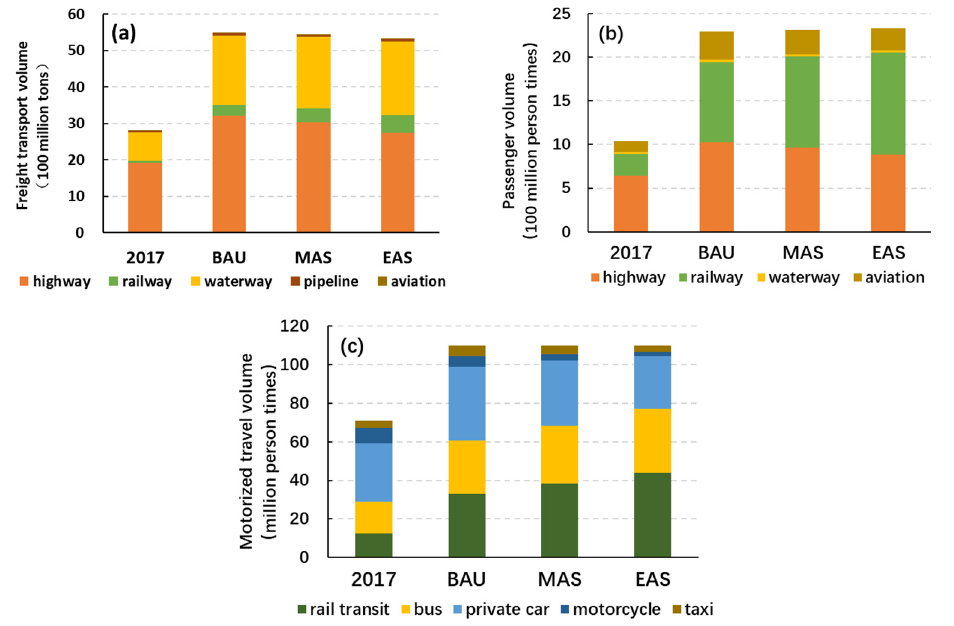
Figure 3. Demand of transportation development of PRD under the base year and three scenarios in 2035: ( a ) freight transport, ( b ) passenger transport, ( c ) urban travel.